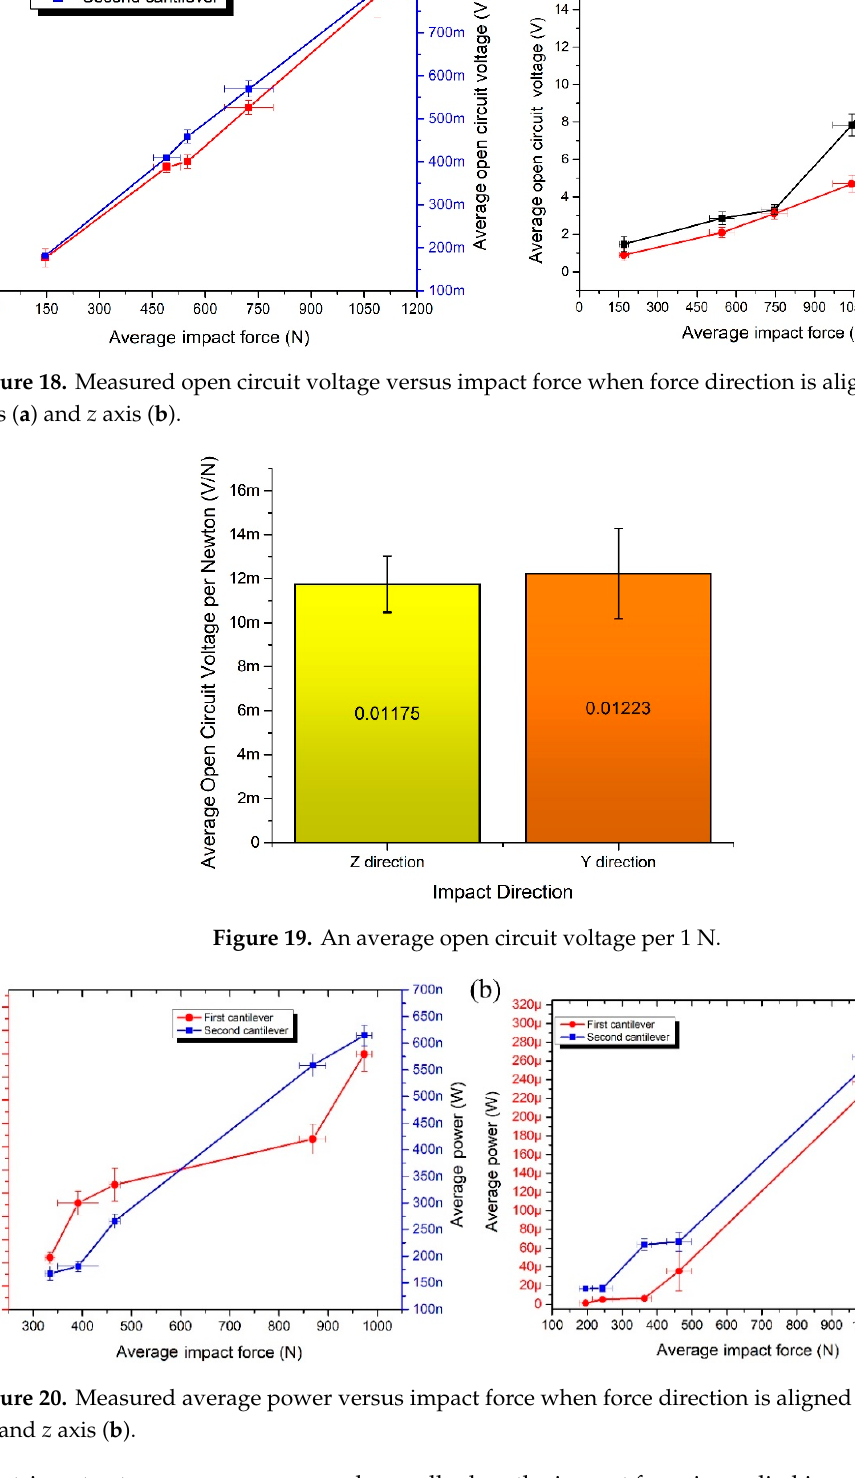
Figure 20. Measured average power versus impact force when force direction is aligned with y axis ( a ) and z axis ( b ). ( a ) and z axis ( b